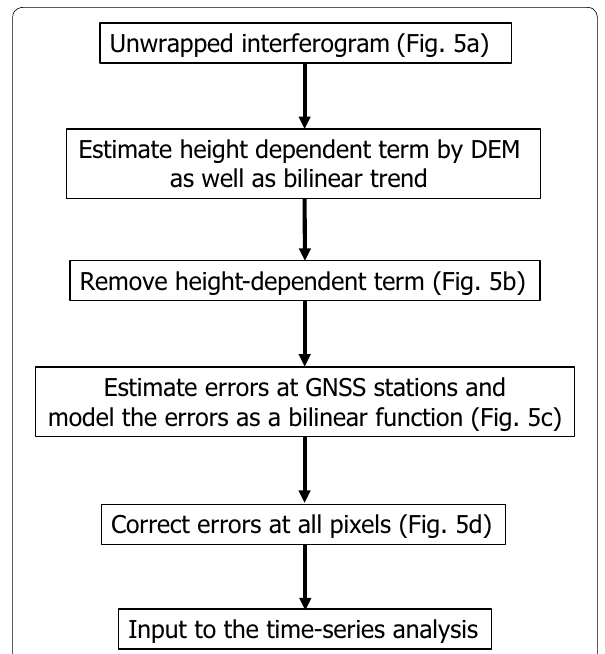
Fig. 4 Flowchart for interferogram